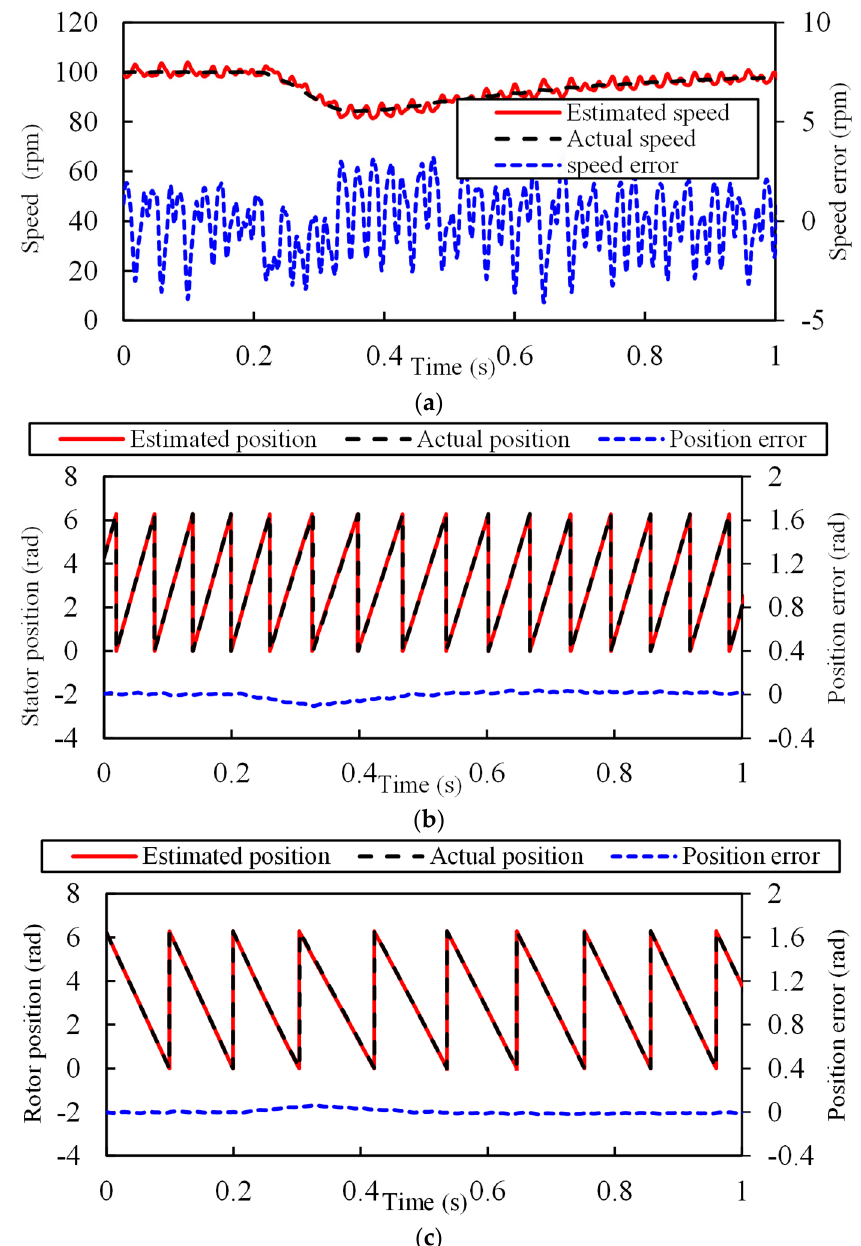
Figure 16. The load step results of estimating from the opposite side. ( a ) Speed. ( b ) Stator position. ( c ) Rotor position.